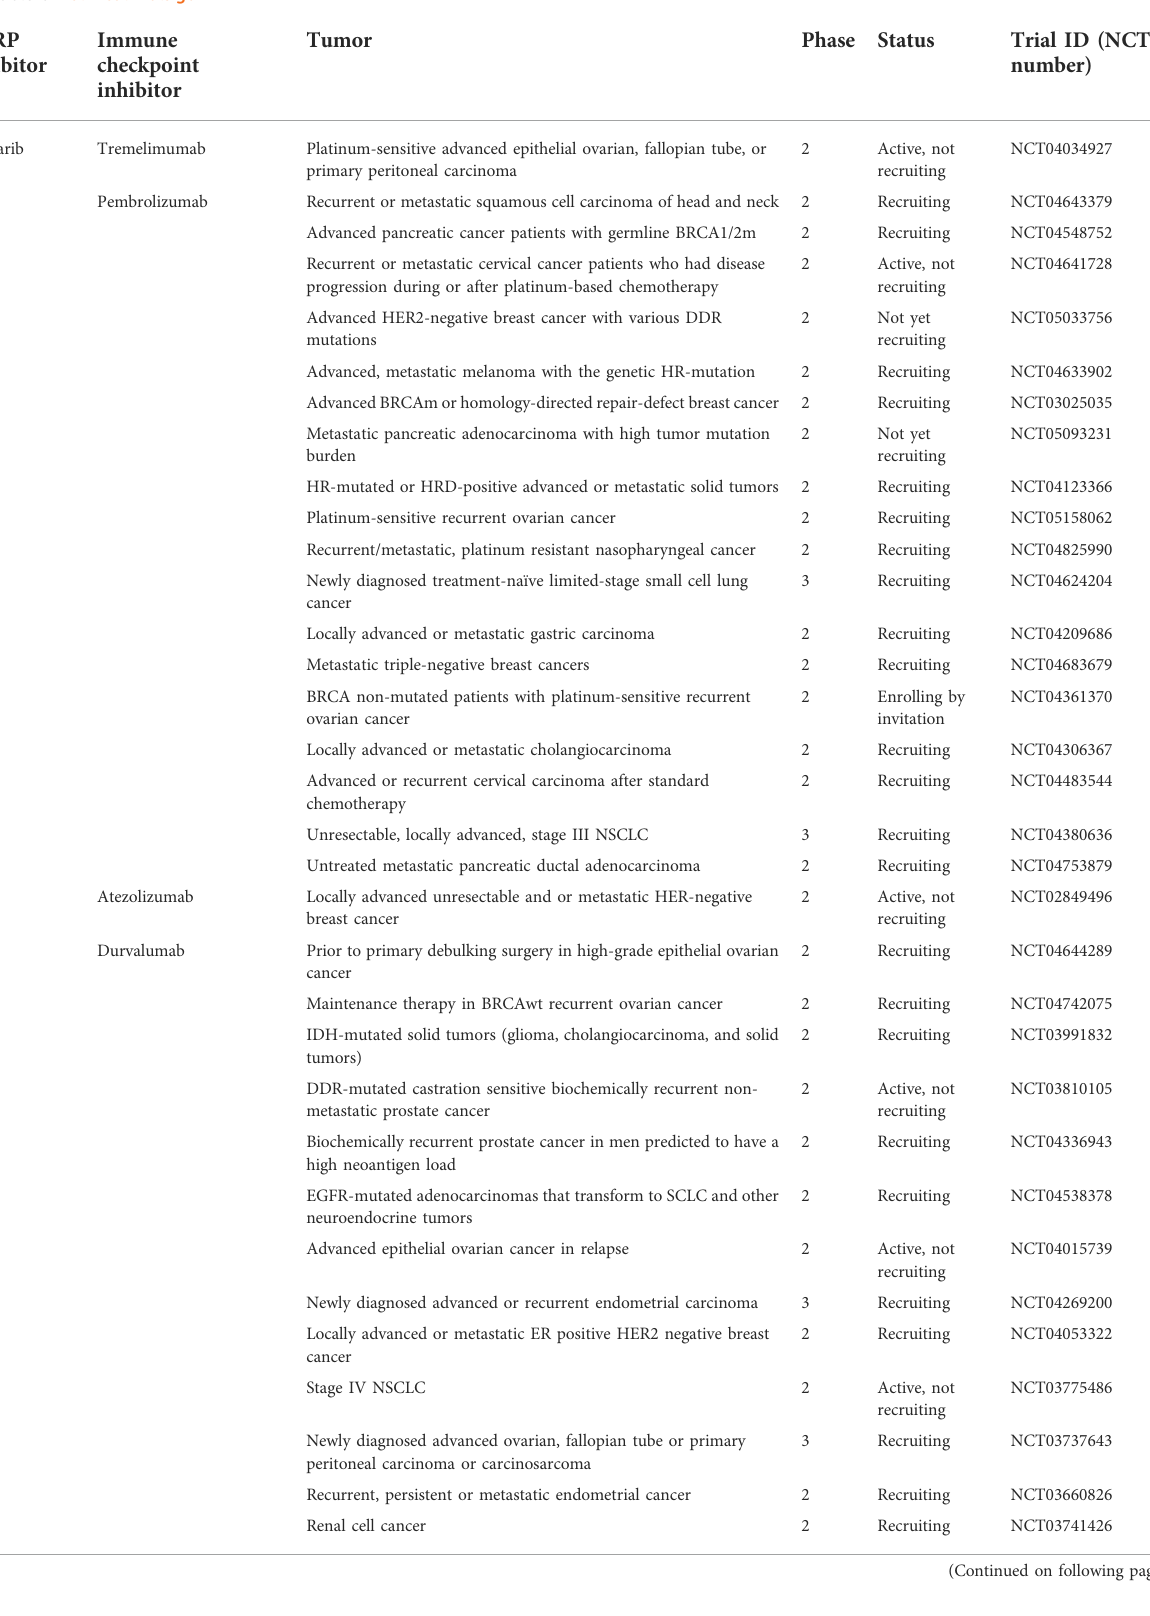
TABLE 3 List of selected PARP inhibitors and immune checkpoint inhibitors combination therapies. Full access to the research studies description is available on ClinicalTrials.gov. PARP